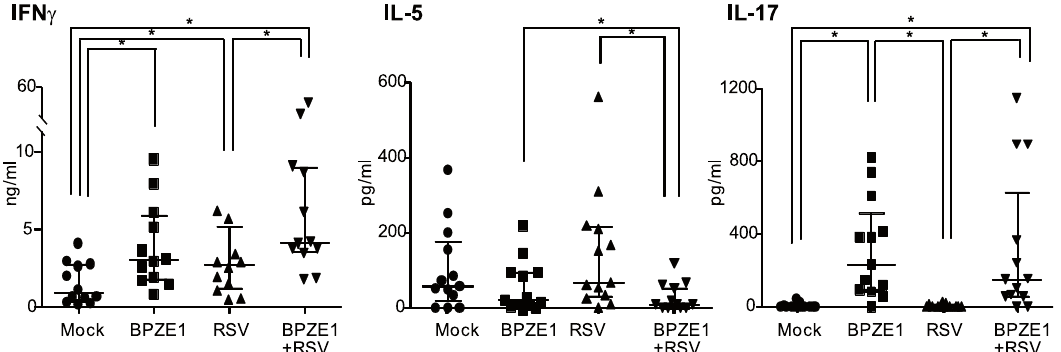
Figure 4. Impact of BPZE1 on RSV-induced T lymphocyte polarization. MDDC were treated with BPZE1 (bacteria/cell ratio of 100:1), RSV (MOI of 1) or both. Mock-infected cells were added as control. After 48 h, treated MDDC were cultured with purified allogeneic CD3 T cells. On day12, supernatants were collected, and IFN- c (Th1), IL-5 (Th2) and IL-17 (Th17) were measured by ELISA. Values are expressed as medians with interquartile range of 13 independent experiments performed with MDDC obtained from different donors and expressed as ng/ml (IFN c ) or pg/ml (IL-5 and IL-17). Statistical significant differences are indicated by * ( P # 0.0083).